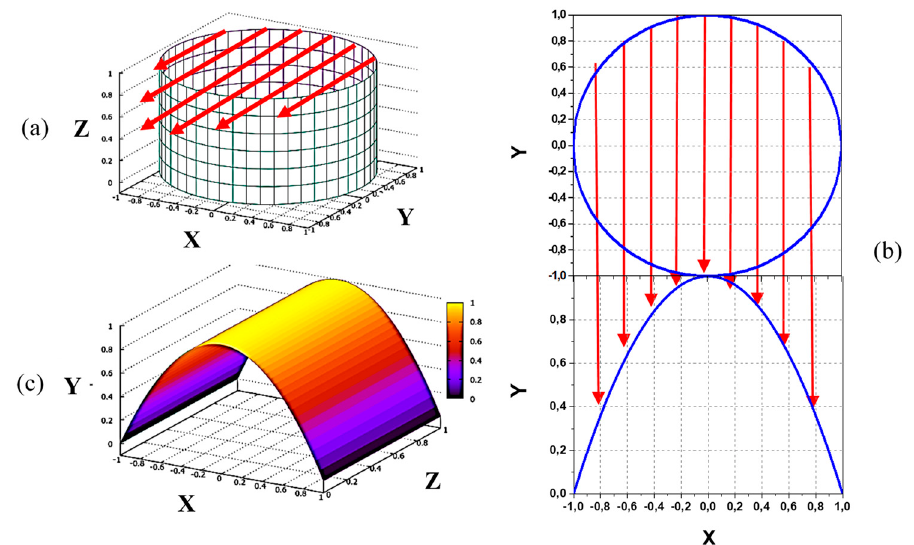
Figure 2. 3D image of sample volume of unit length and circular primary beam of unit radius ( a ), formation of the secondary beam profile in XY plane ( b ), and respective 3D image of the secondary beam ( c ).